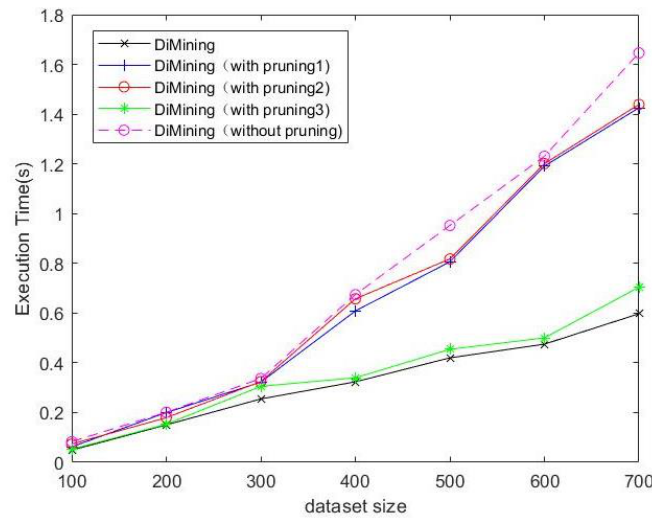
Figure 12. Comparison of pruning strategies.